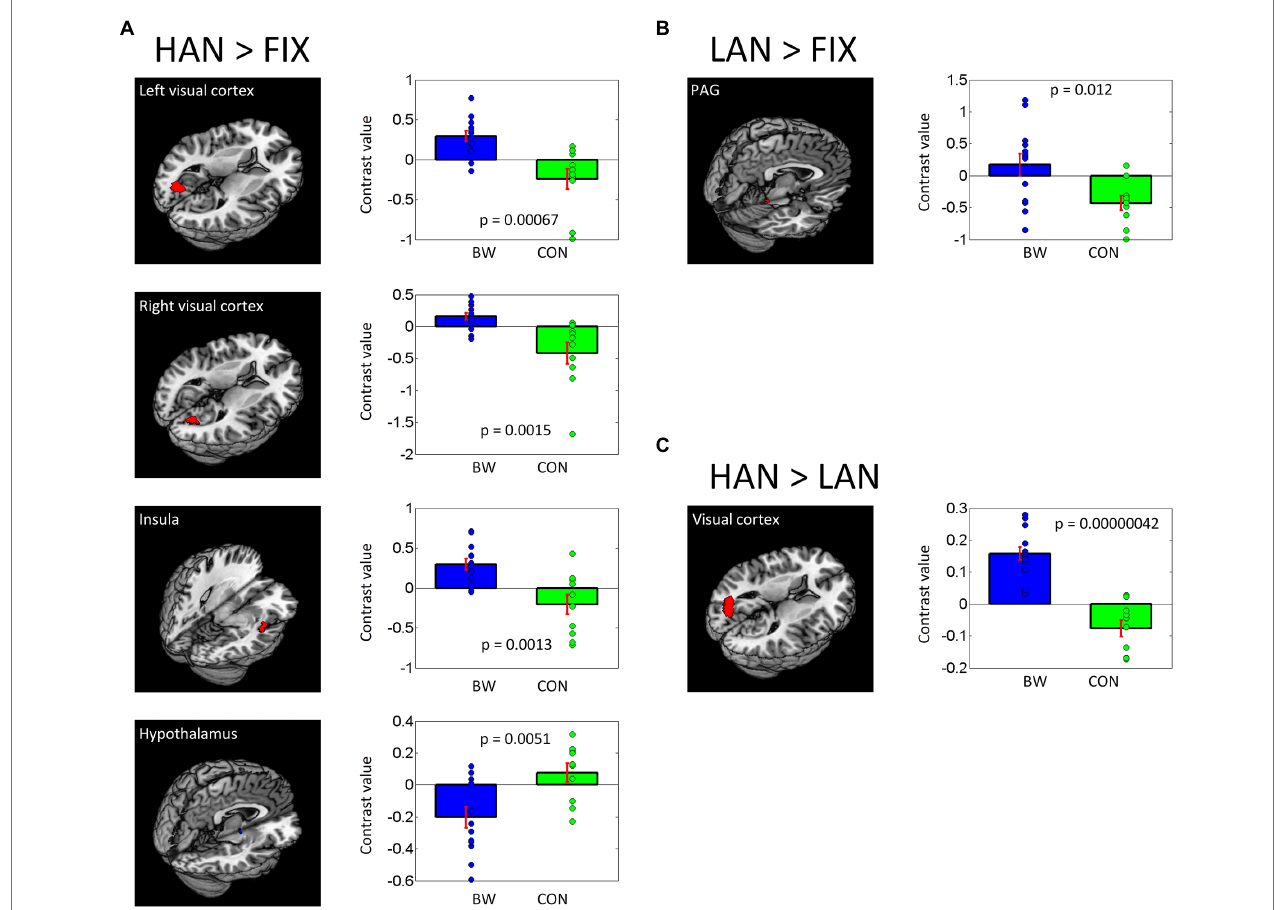
FIGURE 2 | Differences in brain region activations between BWS and CON participant groups during negative IAPS image presentations (A,B) , as well as when responses to HAN and LAN conditions are compared (C) . Individual contrast values (blue and green diamonds) as well as average contrast values (blue and green bars) are